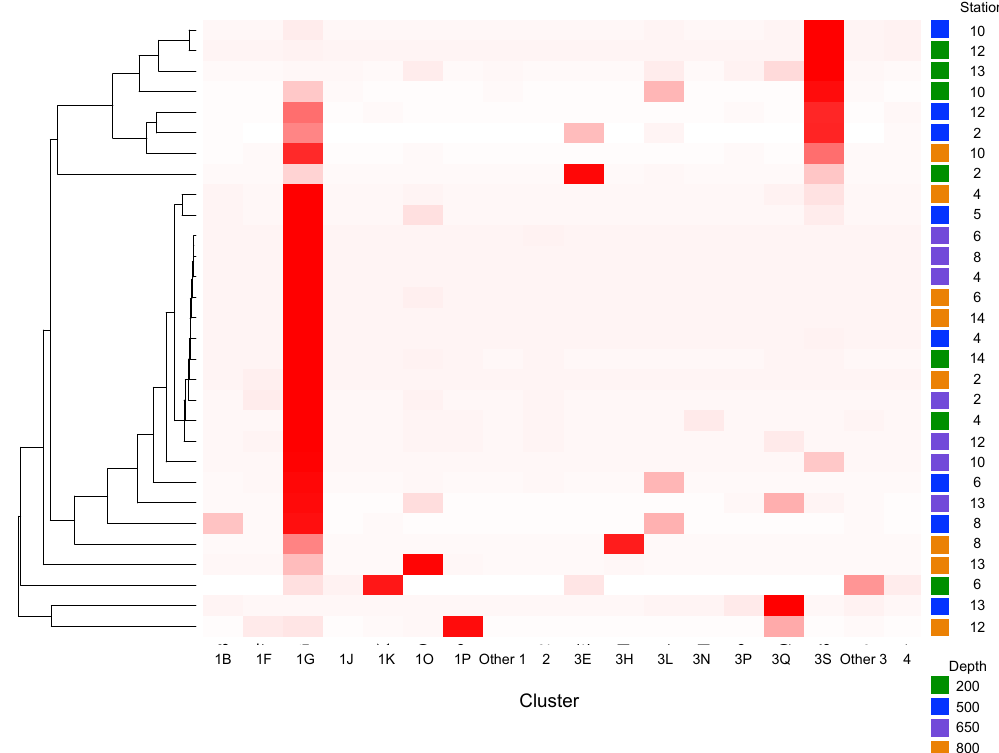
Figure 2. Heatmap of nifH clusters and subclusters across the stations. The Bray–Curtis distances were used to build the dendrogram on the left. Distances were calculated with relative abundances of sequences by subcluster. Subclusters within clusters 1 and 3 that had low relative abundances throughout all samples have been grouped as “other”.